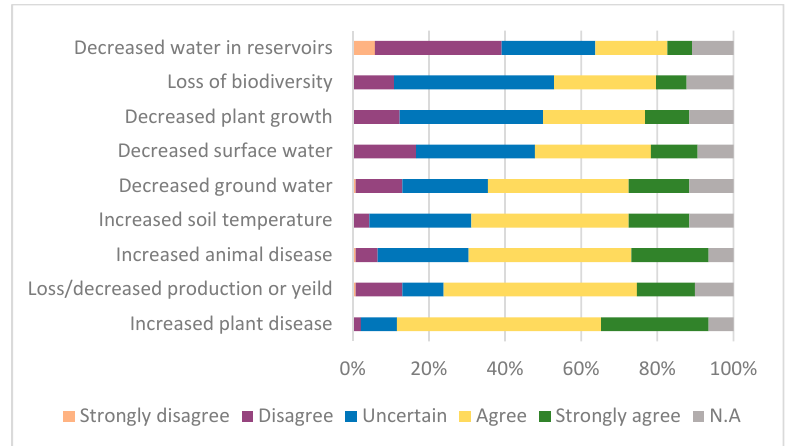
Figure 3. Farmers’ perception of climate impacts. Statements are ranked in ascending order by total percentage of “Agree” and “Strongly agree” (Likert type).